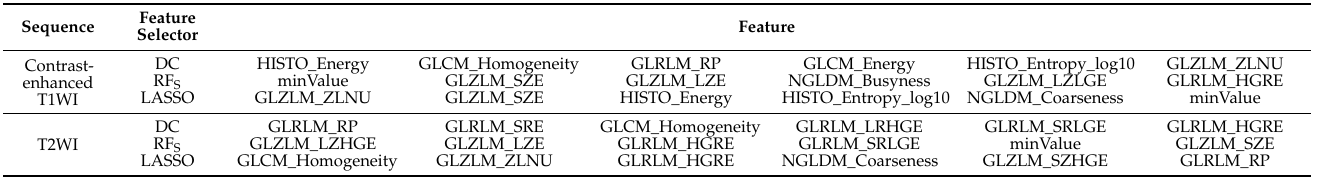
Table 1. The top radiomic features sorted by their sum of contribution in the 100 ranking lists in descending